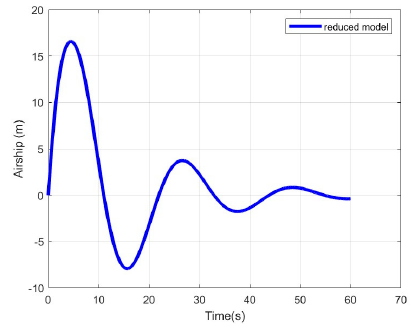
Figure 11. Position of the airship.